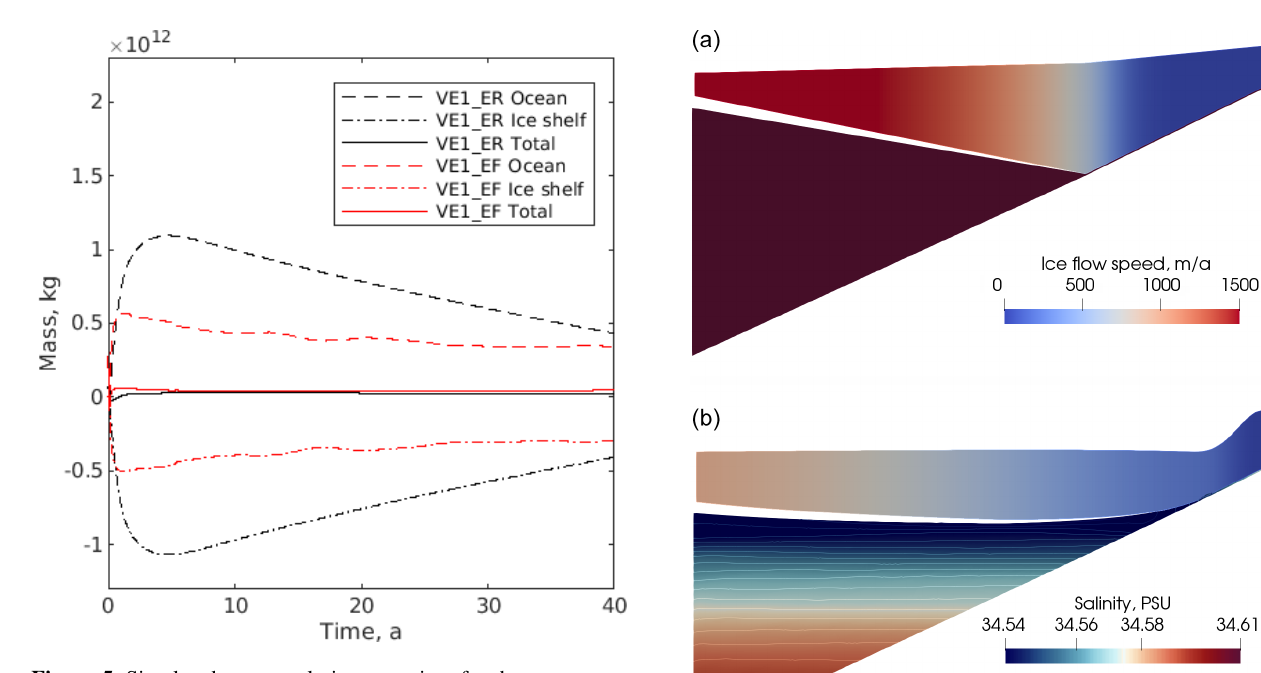
Figure 5. Simulated mass evolution over time for the ocean com- ponent (dashed lines), the ice component (dash-dotted lines), and the total across both components (solid lines) from experiments VE1_ER (black) and VE1_EF (red).